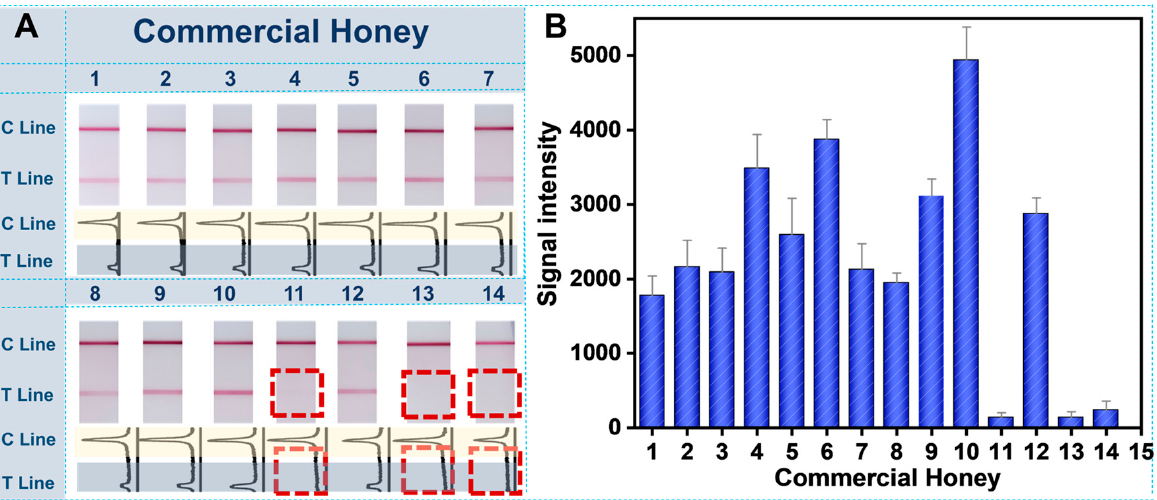
Figure 6. Determination results of 14 commercial honey samples: ( A ) Visual analysis results and corresponding quantitative curves treated by ImageJ; ( B ) Quantitative analysis results by ImageJ.